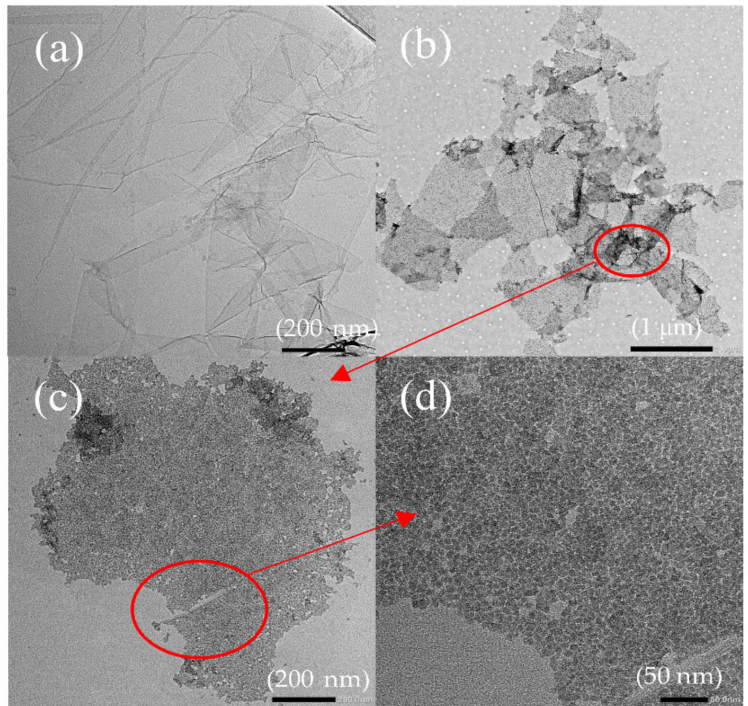
Figure 2. TEM images of GO and GOS. ( a ) GO. ( b ) GOS. ( c ) Locally enlarged images of GOS in ( b ). ( d ) Locally enlarged images of GOS in ( c